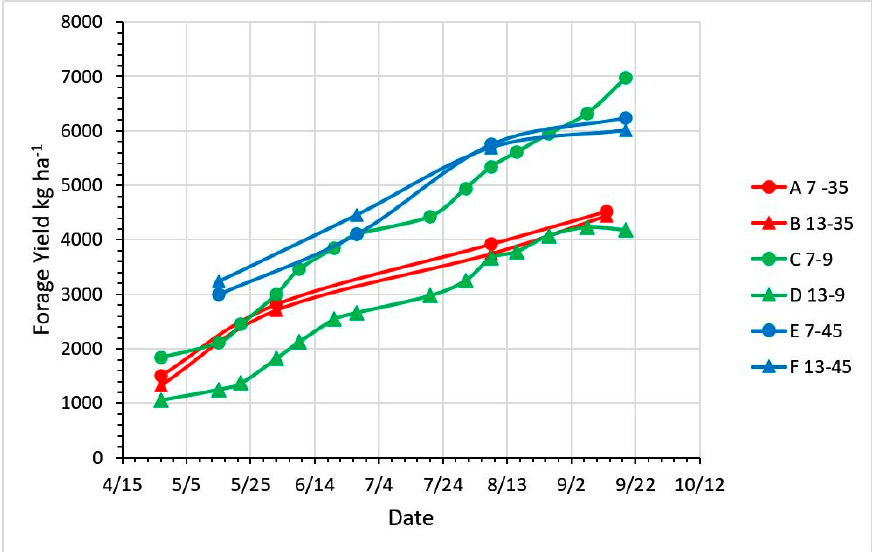
Figure 6. Growth of pasture swards managed under two residual stubble heights (7 and 13 cm) and three cutting intervals, simulating moderate rotational stocking (35 days), continuous stocking (9 days) and infrequent rotational stocking (hay-stage, 45 days) strategies.